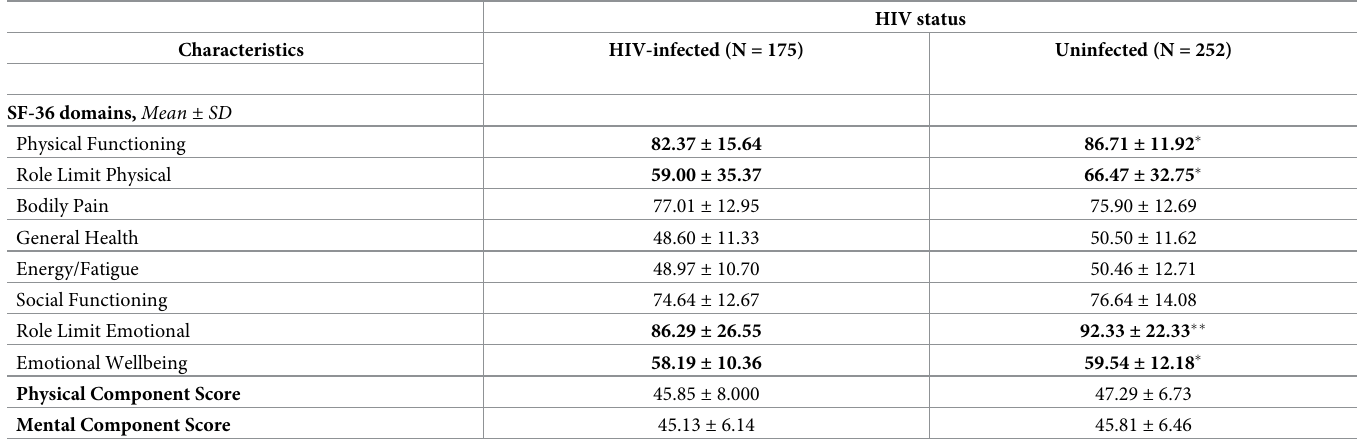
Table 2. SF-36 outcomes by HIV